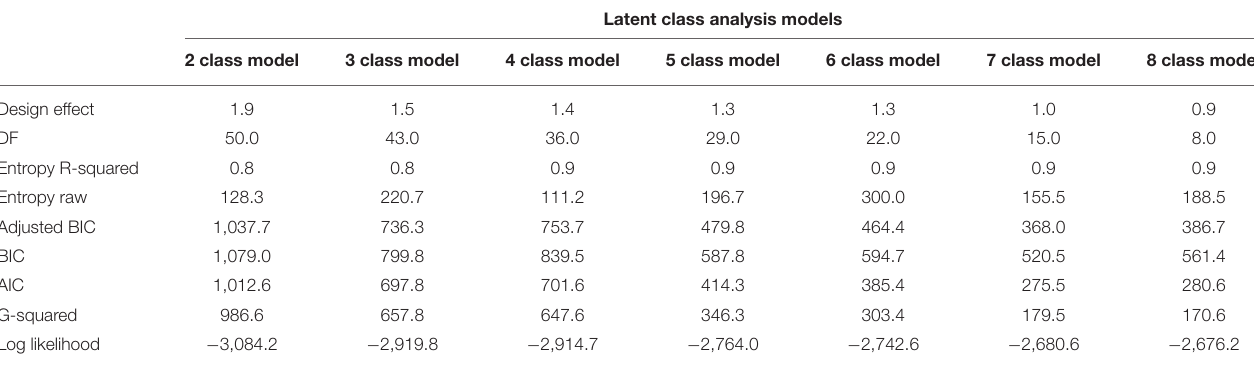
TABLE 4 | Fit statistics for LCA models with different numbers of